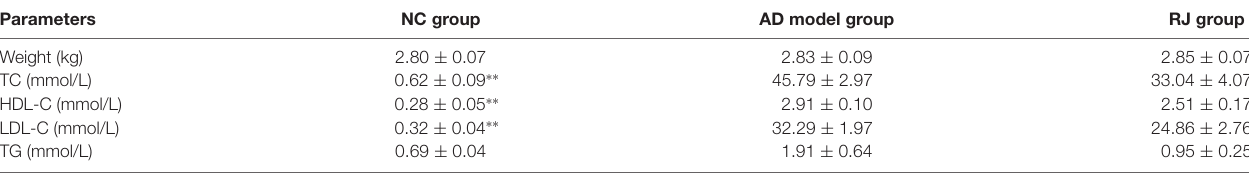
TABLE 1 | Effect of royal jelly (RJ) on weight and blood liquid levels in Alzheimer’s disease (AD) rabbits at 12 weeks.